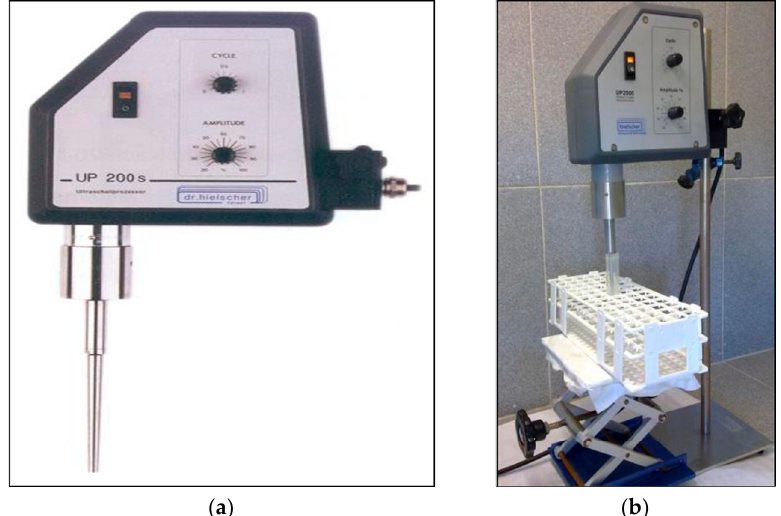
Figure 1. ( a ) US probe Hielscher UP200S stand mounted ultrasonic device with a 1 mm diameter titanium probe; ( b ) US probe with a detail of the vial where the extraction is carried